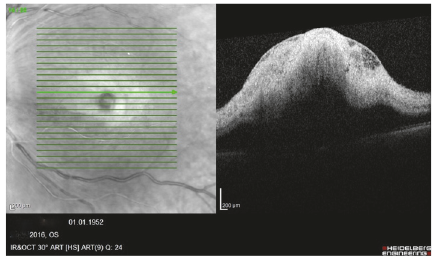
Figure 2: Increased reflectivity of the inner retinal layers in the left eye.